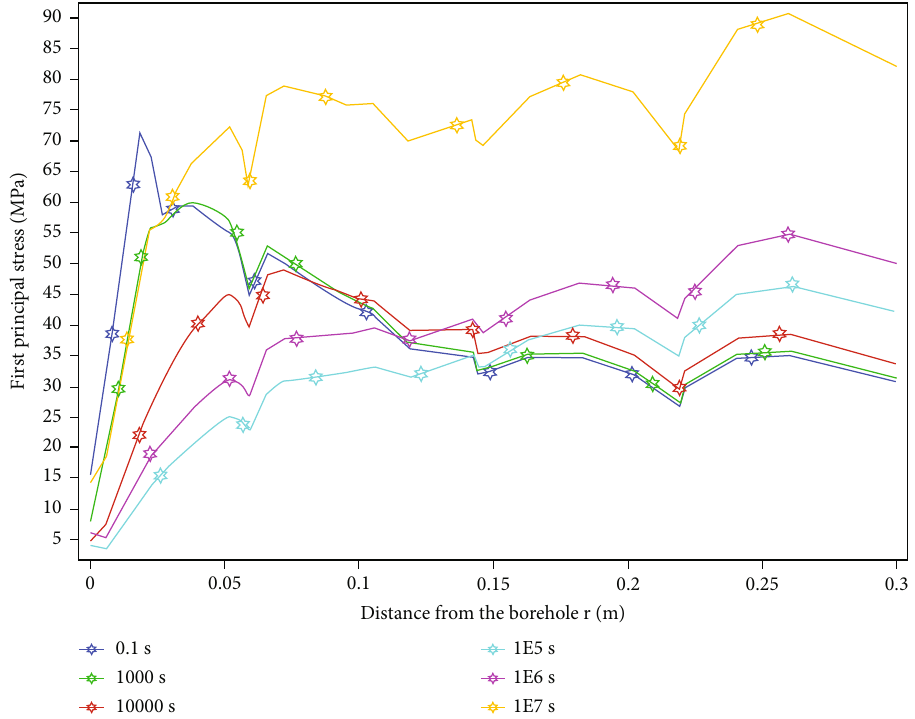
Figure 12: First principal stress in the m = 7 coal rock during CBM